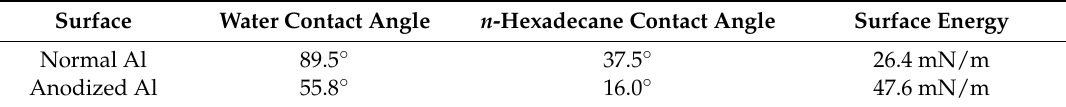
Table 4. Results for surface energy